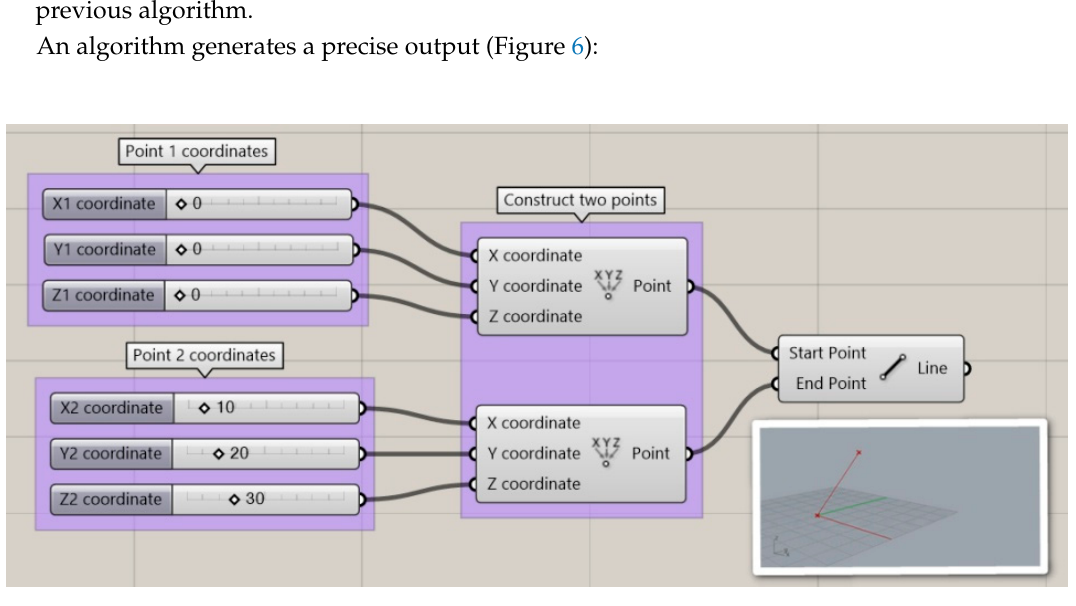
Figure 6. Algorithm programmed in Grasshopper ® to obtain all the straight lines.